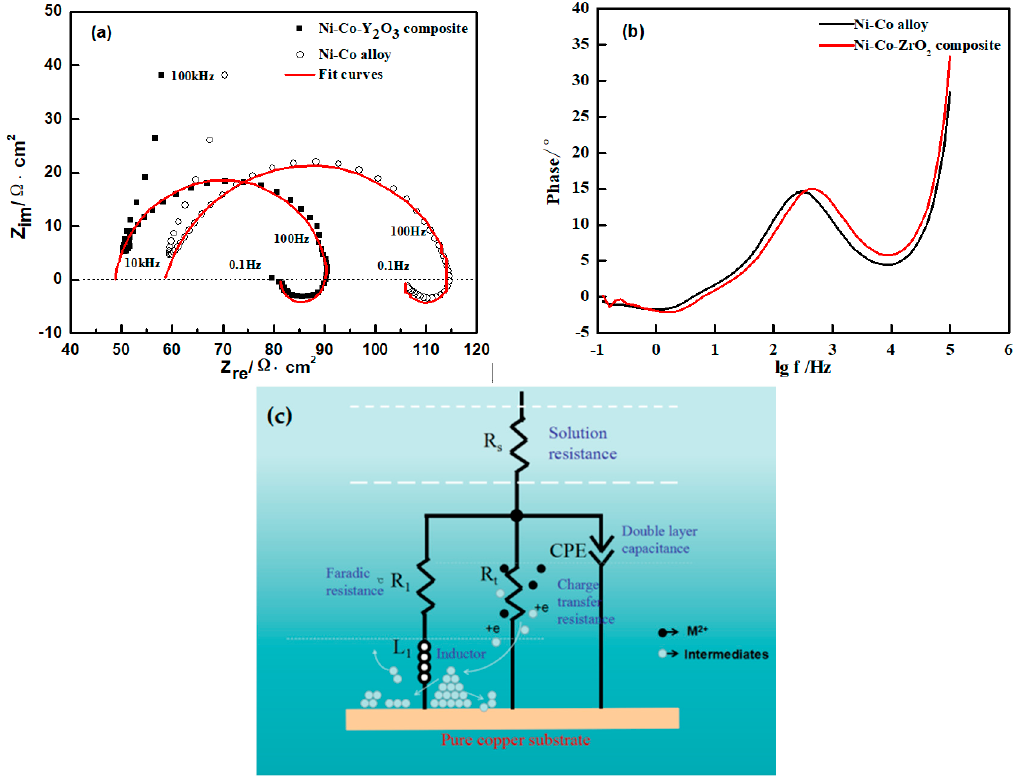
Figure 7. ( a ) Experimental Nyquist plots (with bode) and fitting curves for deposition on pure copper plate in electrolyte, potential was at − 1.10 V, ultrasonic power 100 W, T = 40 °C, and pH = 4; ( b ) Bode spectra; ( c ) Simulated impedance spectra for deposits.